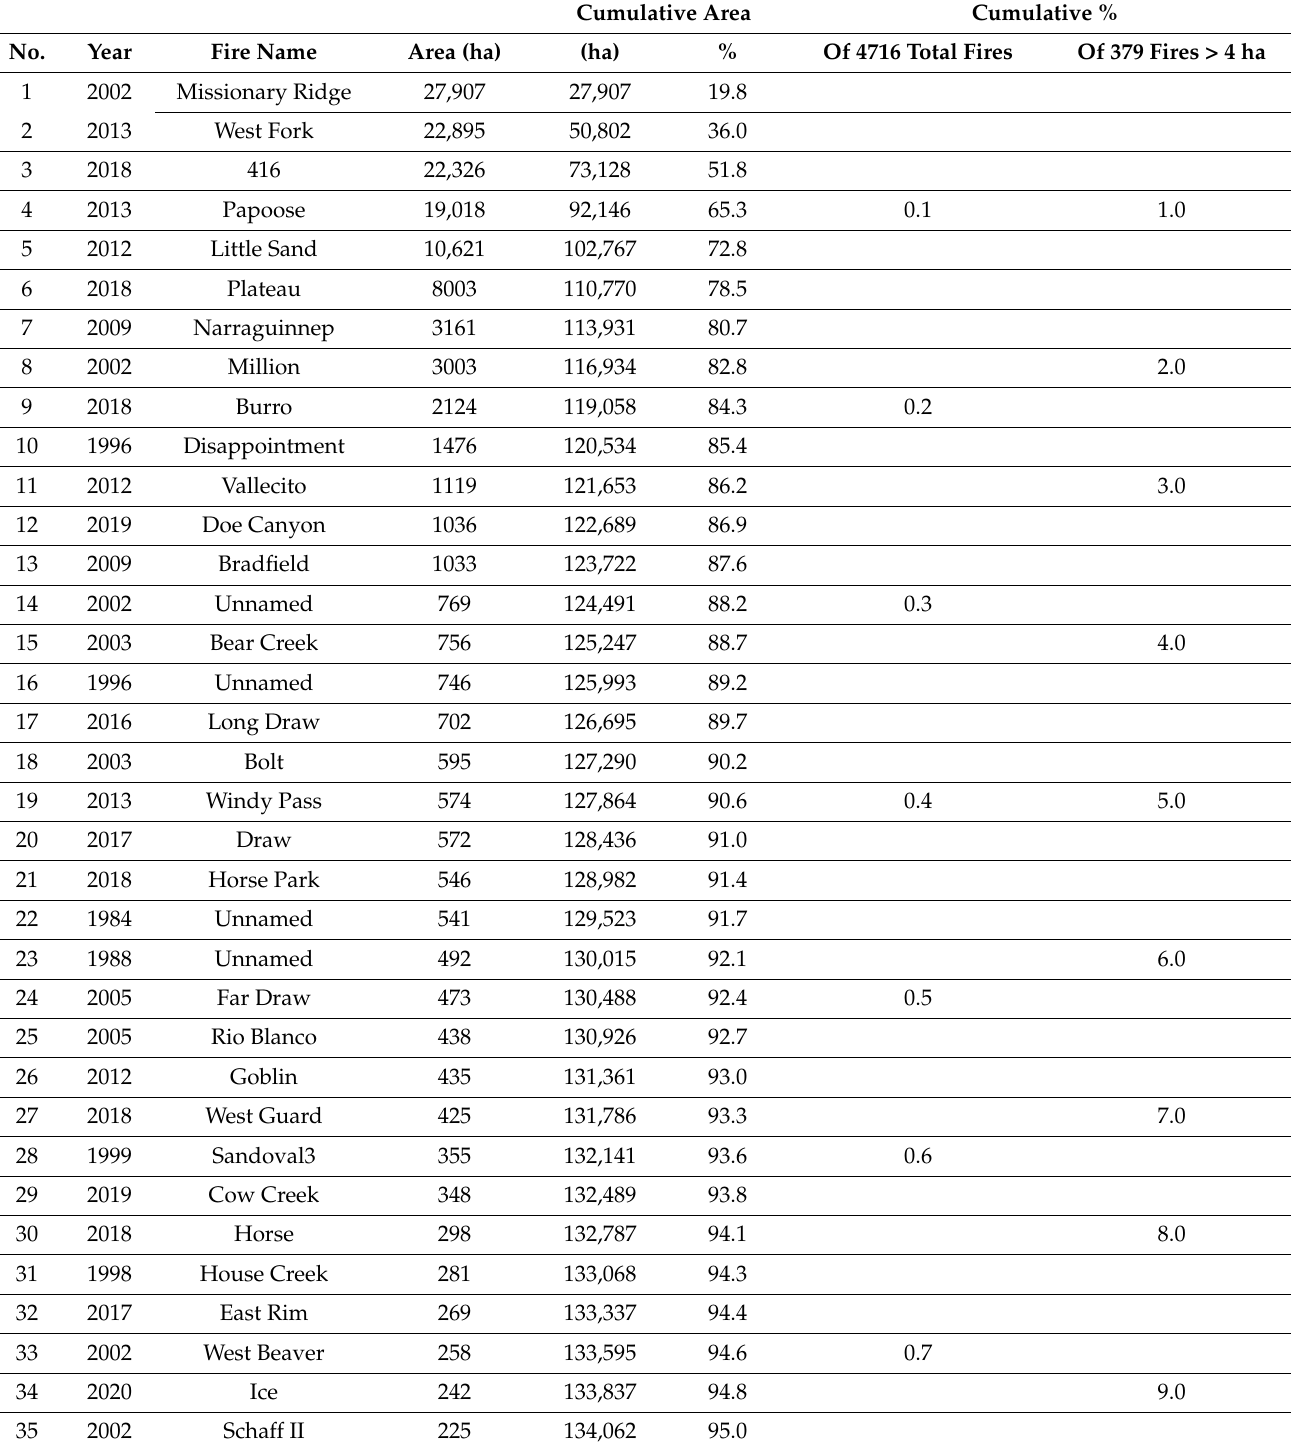
Table 7. Largest wildfires in the San Juan Mountains from 1980 to 2020 in order by decreasing area, also showing cumulative area, cumulative percentage (%) of 141,146 ha of total fire area, as well as the cumulative percentage of 4716 total